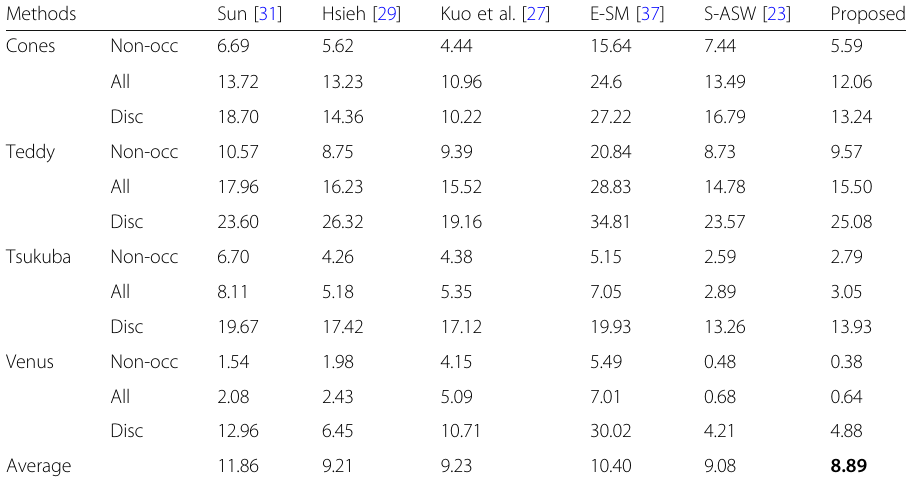
Table 3 Error rate (%) of the proposed and other stereo matching algorithms Methods